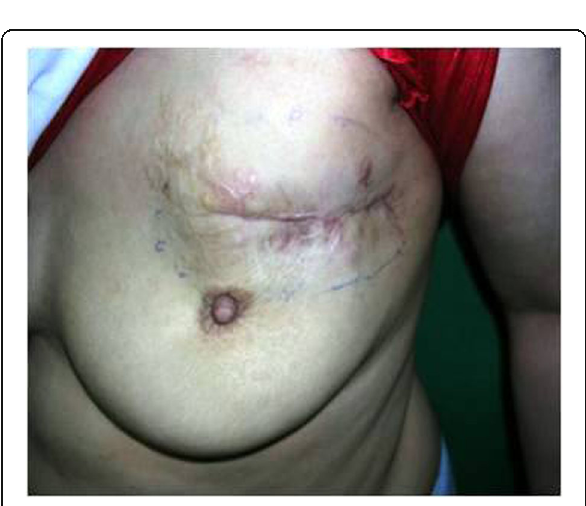
Fig. 1 Case 1, recurrent left breast carcinoid: a young lady with a mass in the upper outer quadrant of left breast pathologically diagnosed as carcinoma with endocrine differentiation and treated by surgery and adjuvant chemoradiotherapy. The mass recurred at the same site implicating the previous scar necessitating aggressive local resection. It proved to be a malignant